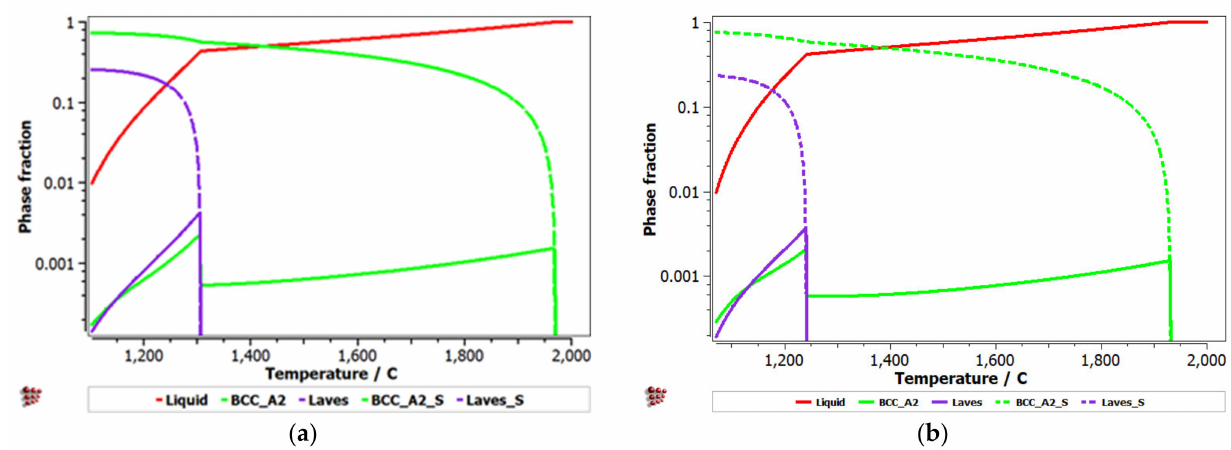
Figure 6. Scheill–Gulliver diagrams for the ( a ) FeTa 0.5 Nb 0.5 TiZr 0.5 and ( b ) FeTa 0.5 Nb 0.5 Ti 1.5 Zr 0.5 alloys.